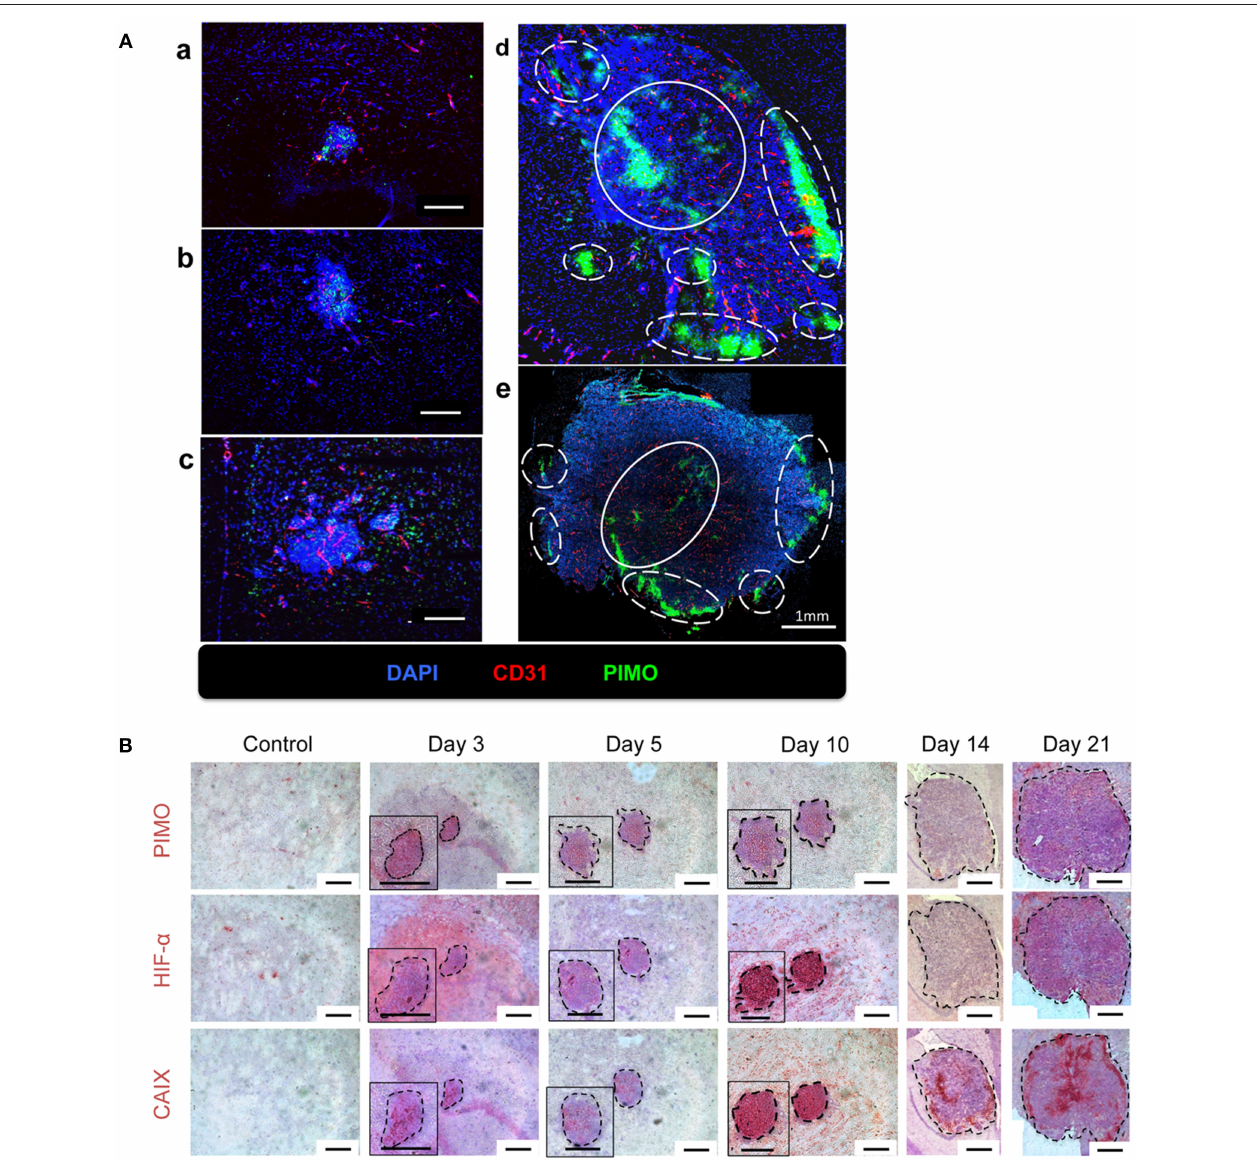
FIGURE 2 | The temporal and spatial pattern of tumor hypoxia-associated markers during tumor progression. (A) Mice were sacrificed on day 3 (a), day 5 (b), day 10 (c), day 14 (d), and day 21 (e) after I.C. inoculation of ALTS1C1 tumors. Tumors were double staining for CD31 (red) and hypoxia marker PIMO (green). Nucleus was stained by DAPI (blue). The peripheral hypoxia was marked with white dotted line and the central hypoxia was marked by white solid line. (B) Representative figures for hypoxia-associated markers, PIMO (brown), HIF1- α (brown), and CAIX (brown) on normal brain tissue (control) and ALTS1C1 tumor tissue. Nucleus was visualized by staining with hematoxylin (blue) and tumor was outlined by black dotted line. Scale bar = 200 µ m.